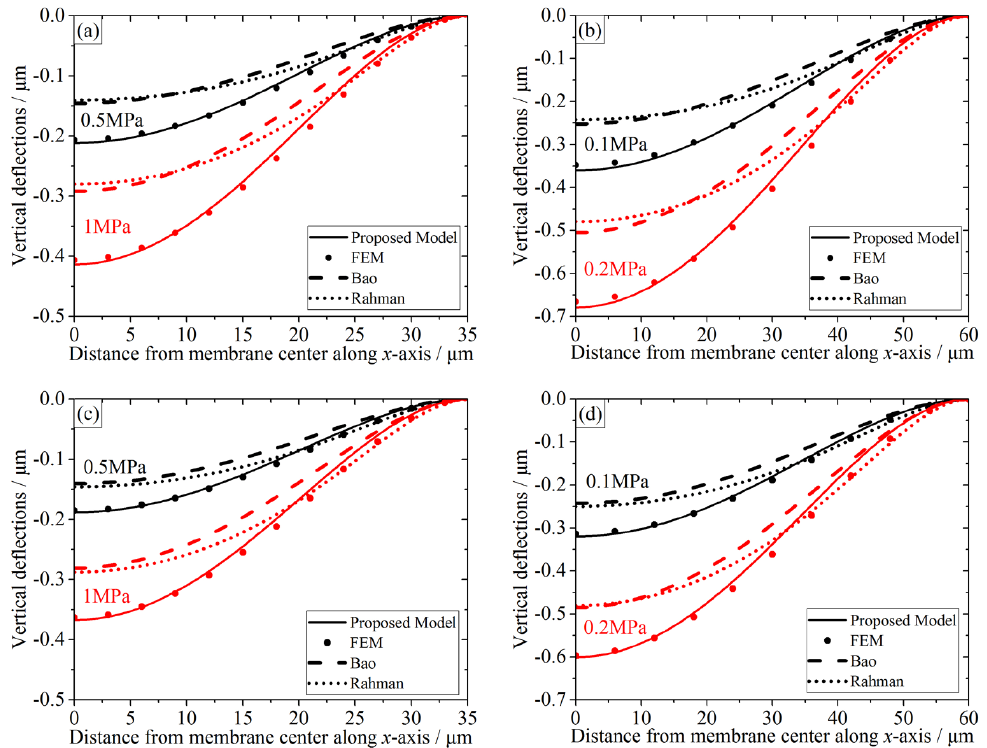
Figure 4. Comparisons of the static deflection profiles of three-layer CMUT membranes predicted by the proposed model, finite element method (FEM), and other literatures, plotted from center to membrane edge. Different colors represent different external pressures. Deflection profiles of ( a ) CMUT A; ( b ) CMUT B; ( c ) CMUT C; and ( d ) CMUT D. Table 3. Static deflection error analyses of three-layer CMUT membranes for different external pressures. Model Index